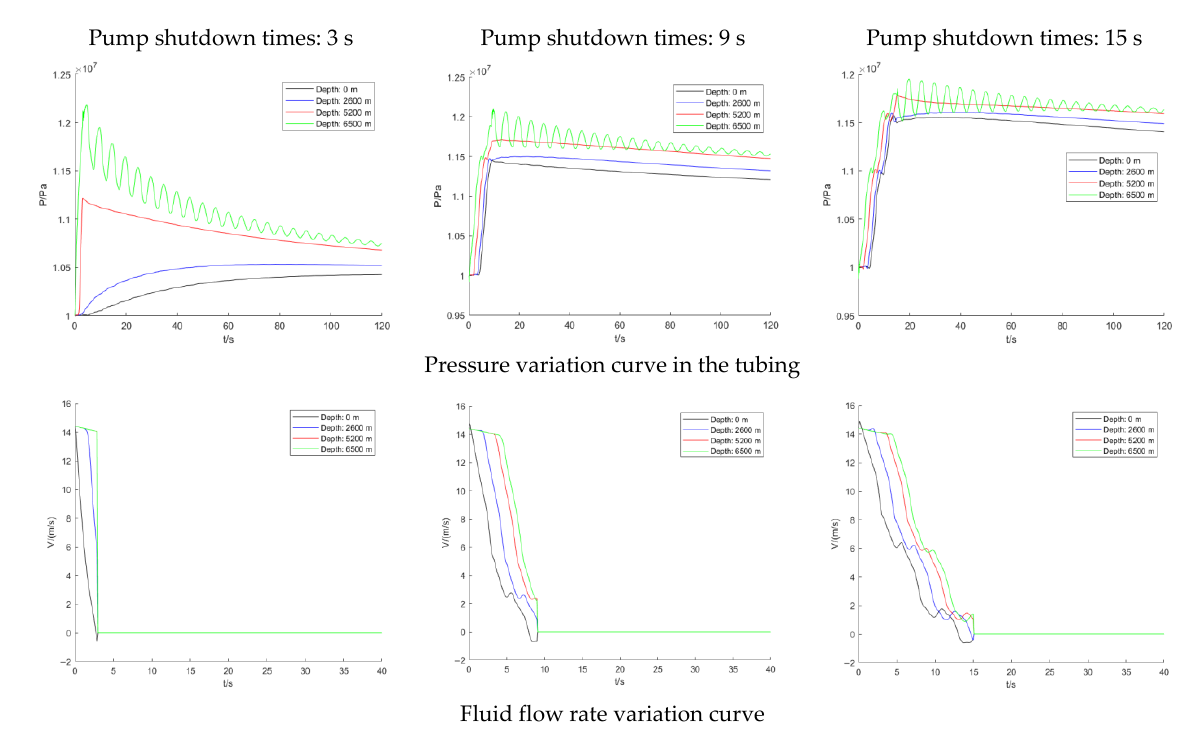
Figure 5. Variation curves of flow field parameters under different pump shutdown times.